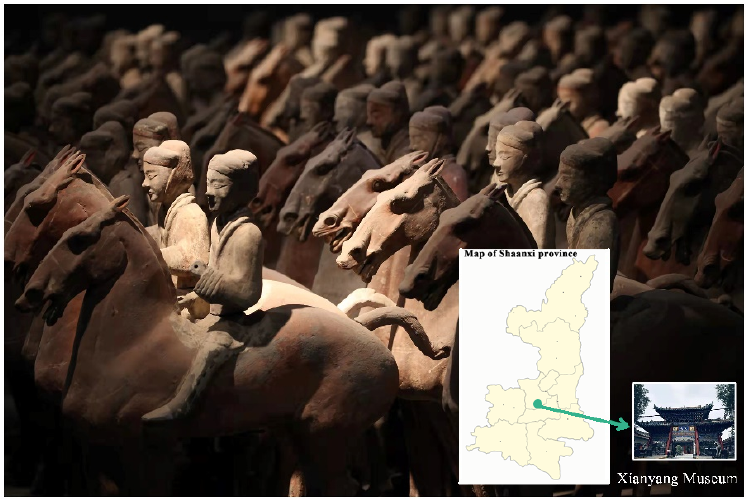
Figure 1. Location of the painted terracotta warriors and horses of the Western Han Dynasty in Yangjiawan, Shaanxi.